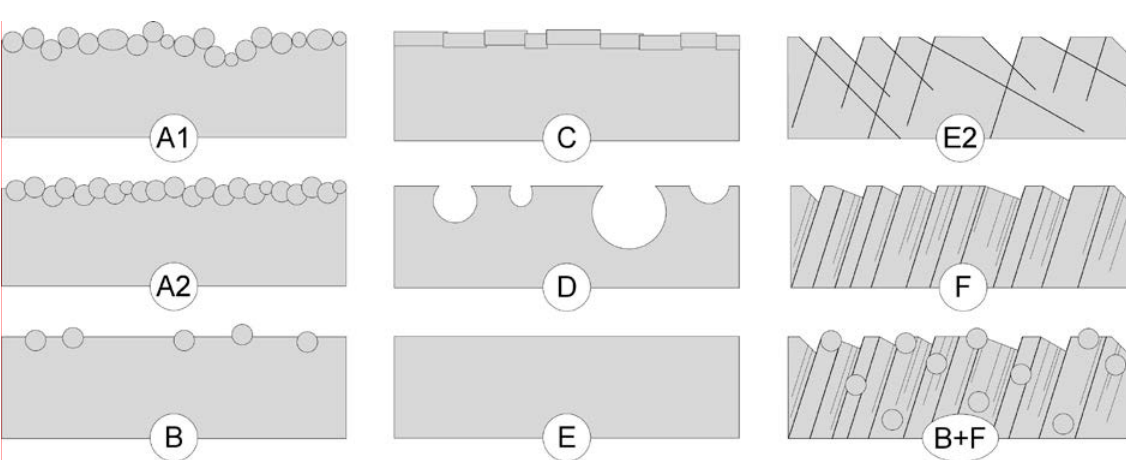
Figure 2. Classification of millstone rocks according to Fronteau & Boyer 2011 (modified). A1: granular materials with low cohesion, A2: granular materials with high cohesion, B: heterogeneous material with few abrasive grains in a “soft” matrix, C: crystalline materials (grained), D: vacuolar materials, E: massive materials, E2: massive materials with fracture network, F: foliated or heavily laminated materials, B+F: example of a material with composite properties (foliated and